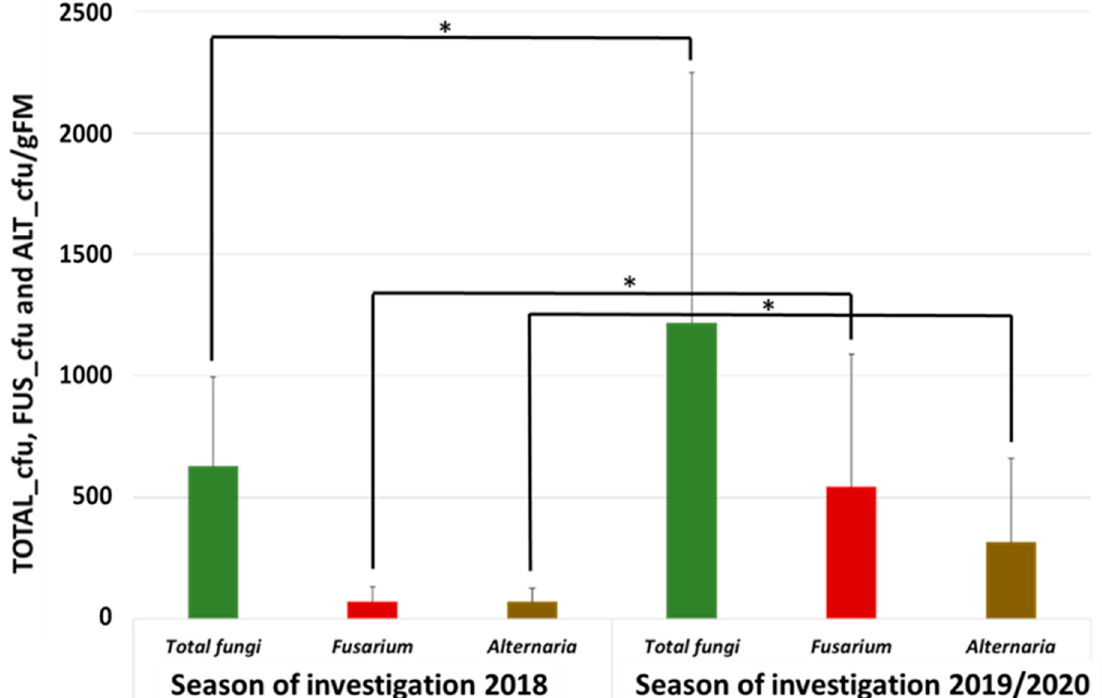
Figure 3. Mean values of the colony-forming units of total fungi (TOTAL_cfu/gFM), Fusarium (FUS_cfu/gFM) and Alternaria (ALT_cfu/gFM) in 2018 ( n = 81) and 2019/2020 ( n = 81) isolated from overwintered plant material at the edges of nine kettle holes in the AgroScapeLab Quillow. The plant species were summarized in Table 1, and the fungal abundance (expressed as cfu/gFM) was averaged over all plant samples in each year. The mean values are plotted with their standard deviation of the mean. Asterisk brackets indicate significant differences (* p <